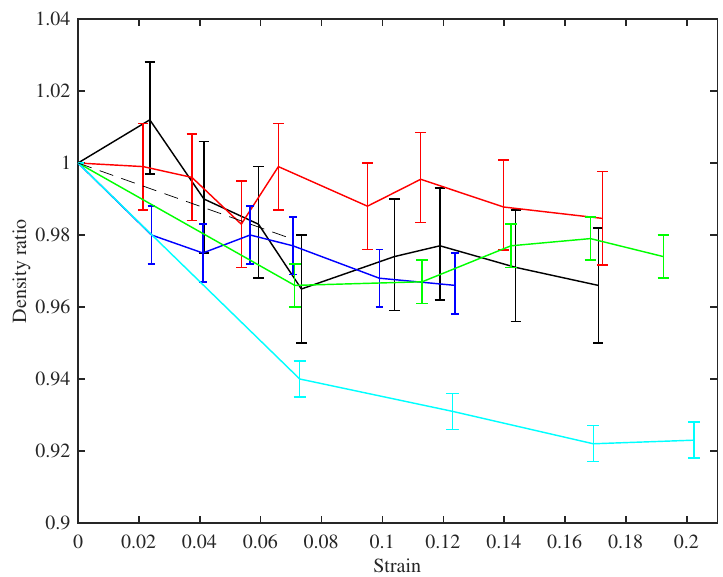
Figure 4. The ratio of the bulk density of the stretched strings to that of the unstretched strings plotted against the strain. The error bars indicate the range of values that could be expected due to the resolution limit of the manual micrometer used to measure the string diameter. Colours identify the di ff erent tested strings (Table 1): black (8:A6), red (14:A5), blue (5:A4), green (23a:A3), cyan (29:E3). The dashed line shows the expected reduction in the density ratio for small values of